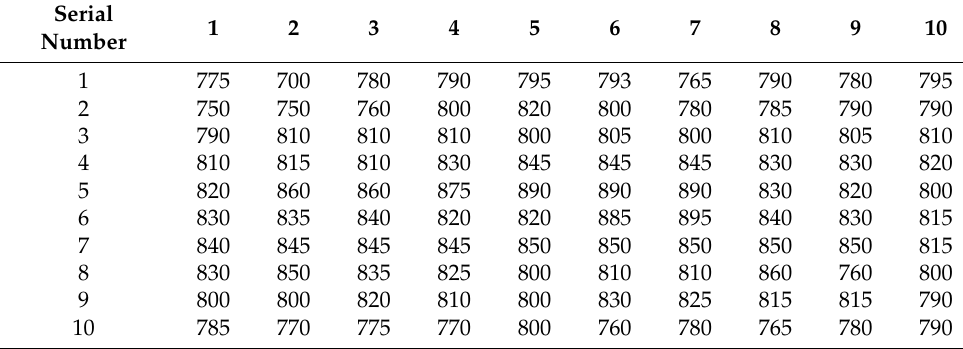
Table 2. Manual measurement of rice plant height.